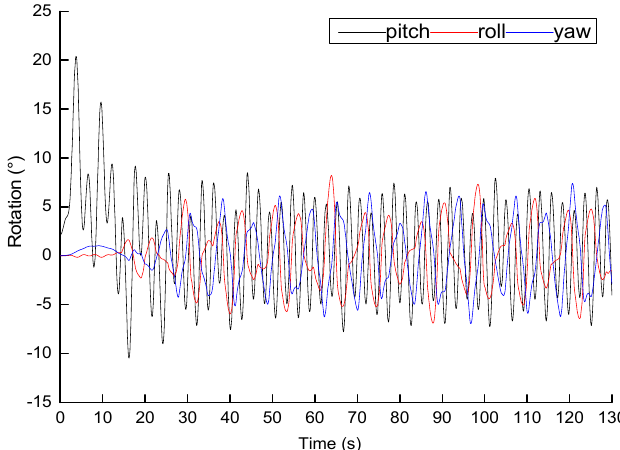
Figure 12. The angle variations of the pitch, roll, and yaw in scheme 3.